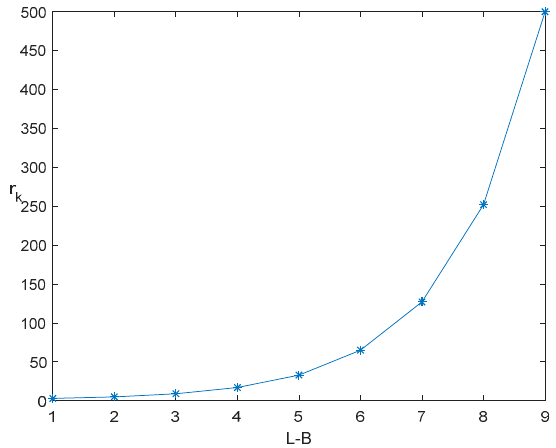
Figure 9. Relationship between r k and L-B.